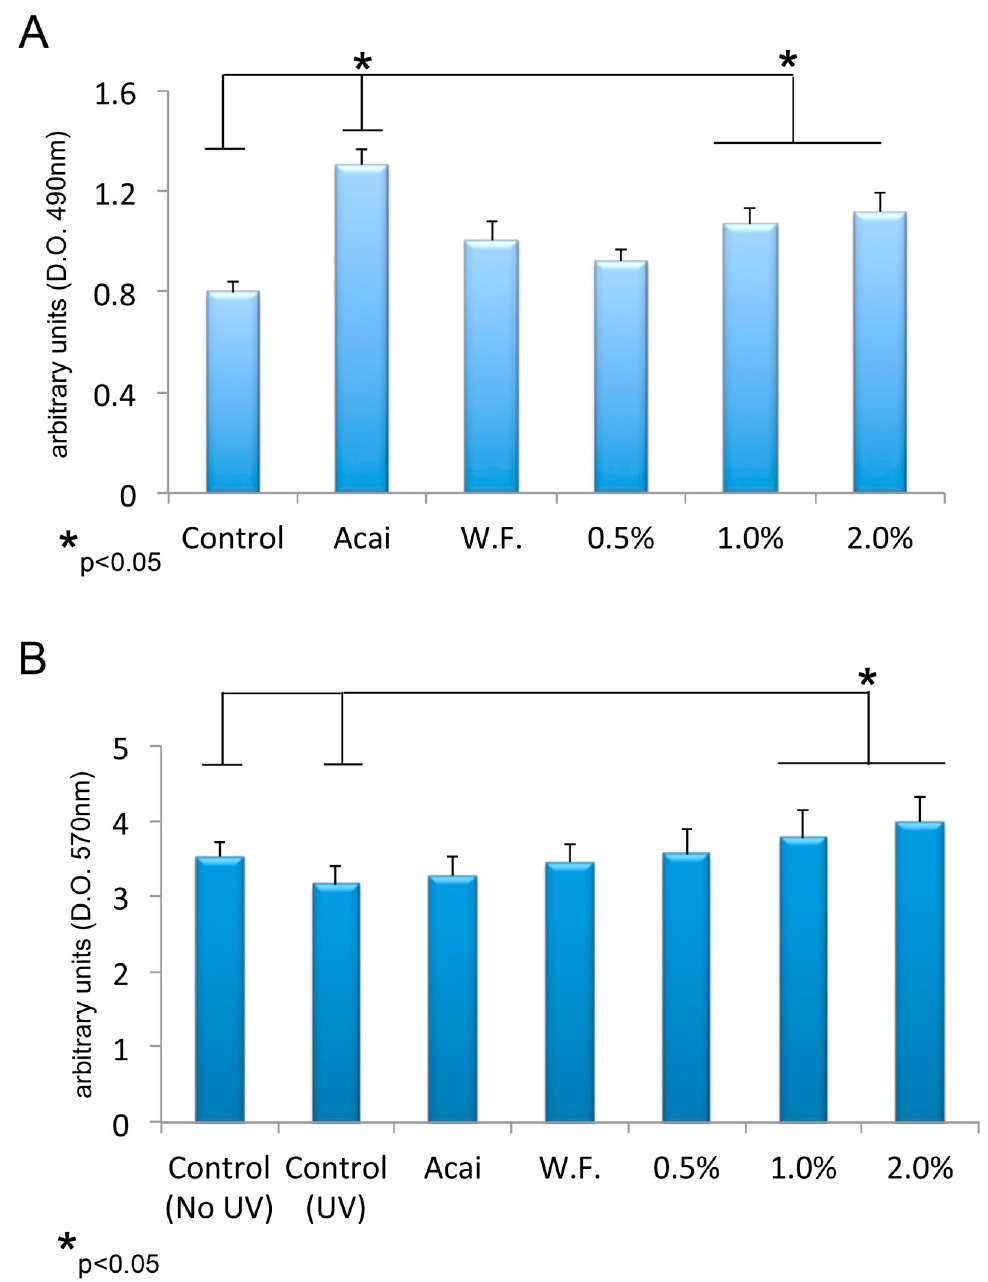
Figure 4. Results for the assessment of the metabolic activity of viable cells (MTS) ( A ) and Total Antioxidant Capacity (TAC); ( B ) for pure açai extract (Acai), formulations without açai extract (W.F.), formulations with 0.5, 1, and 2% of açai extract. For the TAC essay, experiments were carried out in presence of two controls, one corresponding to non-irradiated cells, and one corresponding to irradiated cells.